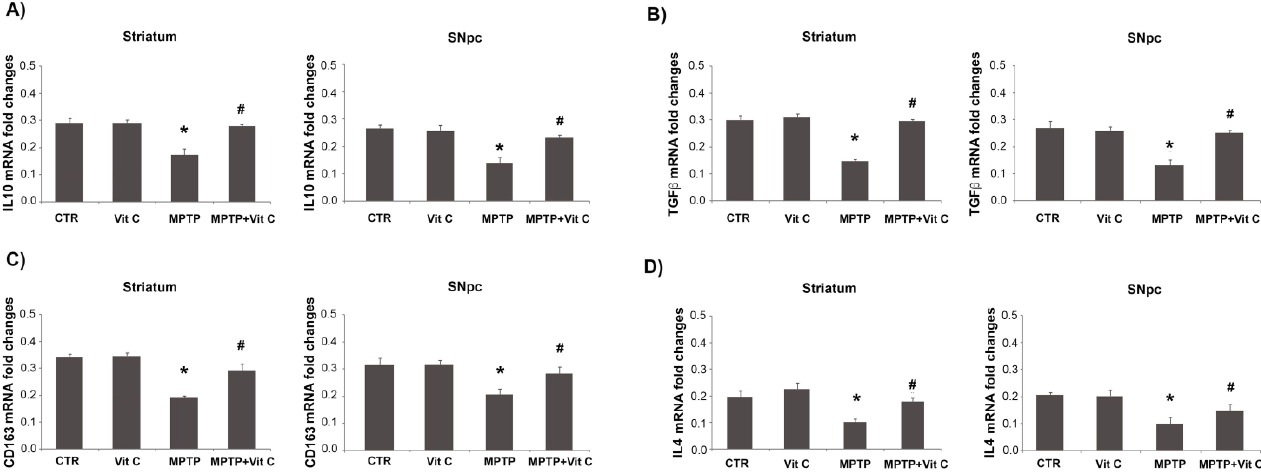
Figure 9. Effects of Vit C on the expression of anti-inflammatory markers in MPTP-treated mice. Real-time PCR analysis of ( A ) IL-10, ( B ) TGF-β, ( C ) CD163, and ( D ) IL-4 mRNA expression levels in controls (CTR), mice treated with Vitamin C (VIT C), MPTP, MPTP, and Vitamin C (MPTP+ VIT C) in striatum ( left ) and SNpc ( right ). Results are presented as mRNA fold changes relative to GAPDH used as resident control. Data are presented as mean ± SD (* p < 0.05 vs. CTR; # p < 0.05 vs.